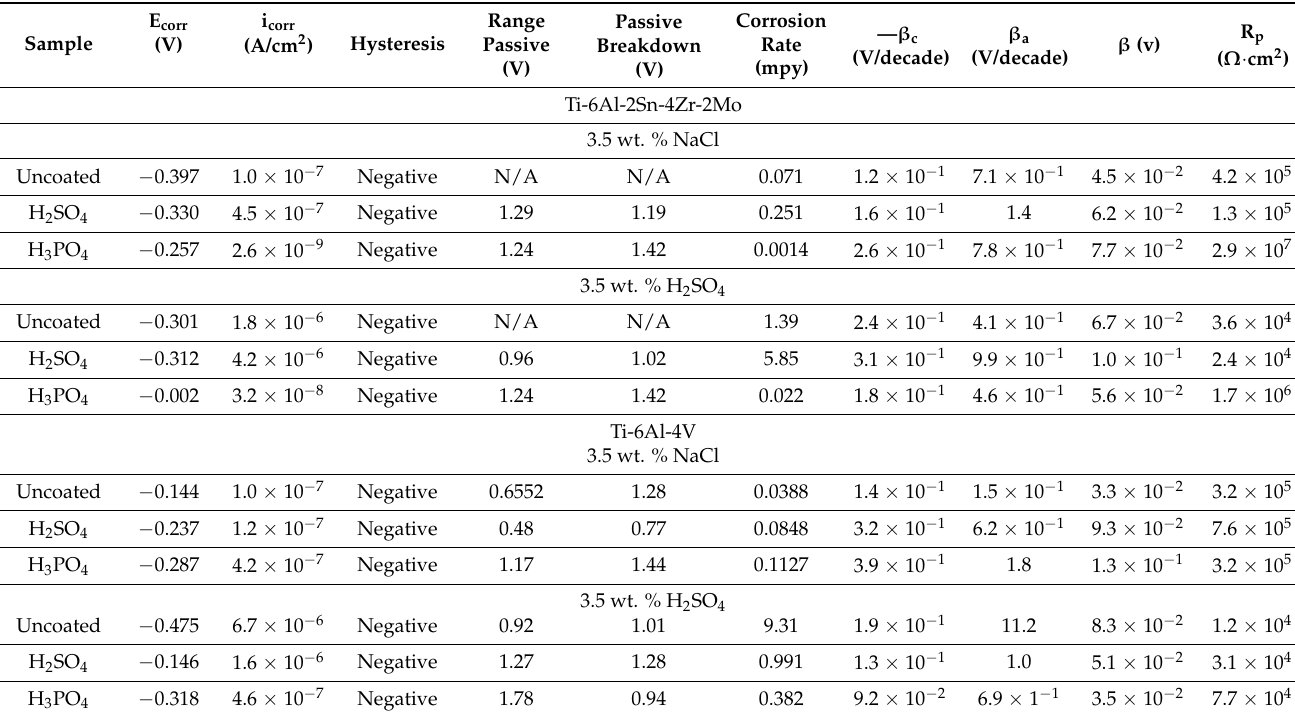
Table 2. Parameters obtained by